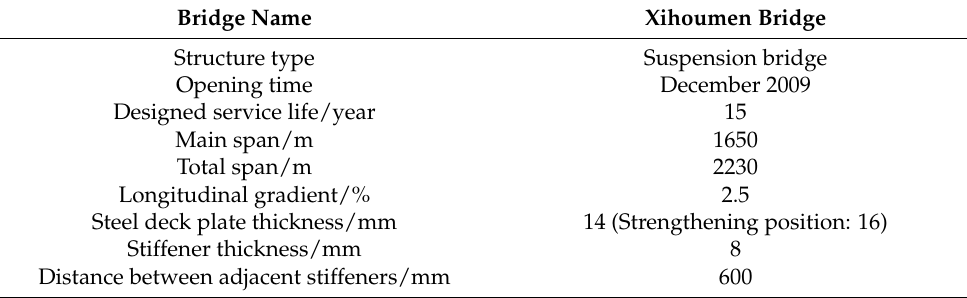
Table 1. Main parameters of